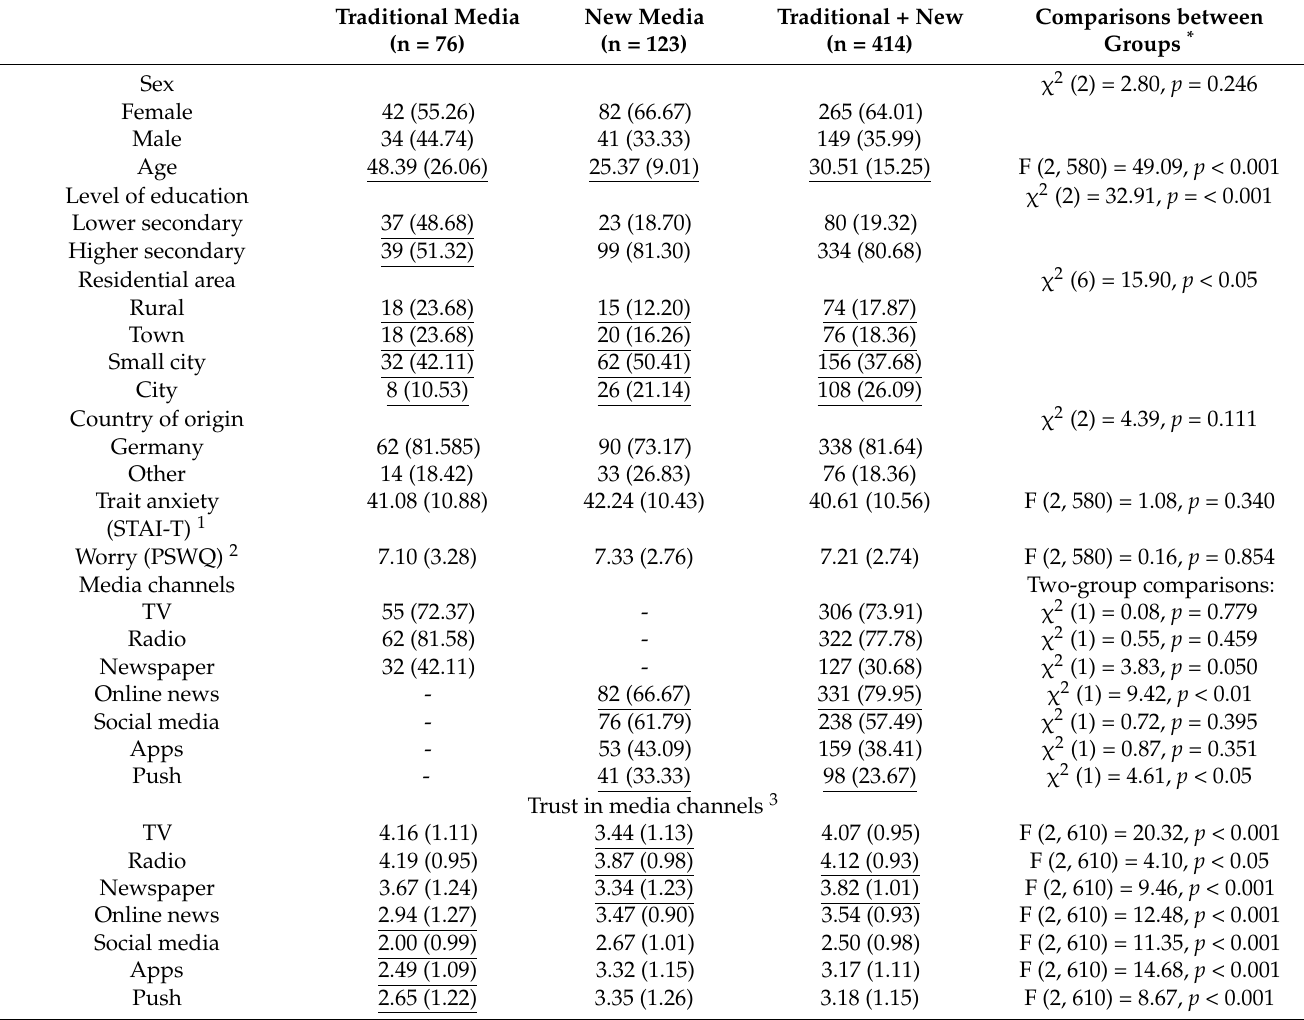
Table 1. Comparison of mean values and relative frequencies of sociodemographic and psychosocial variables between different groups of media use for warning purposes (i.e., traditional, new, or mixed media) (imputed data set; N =